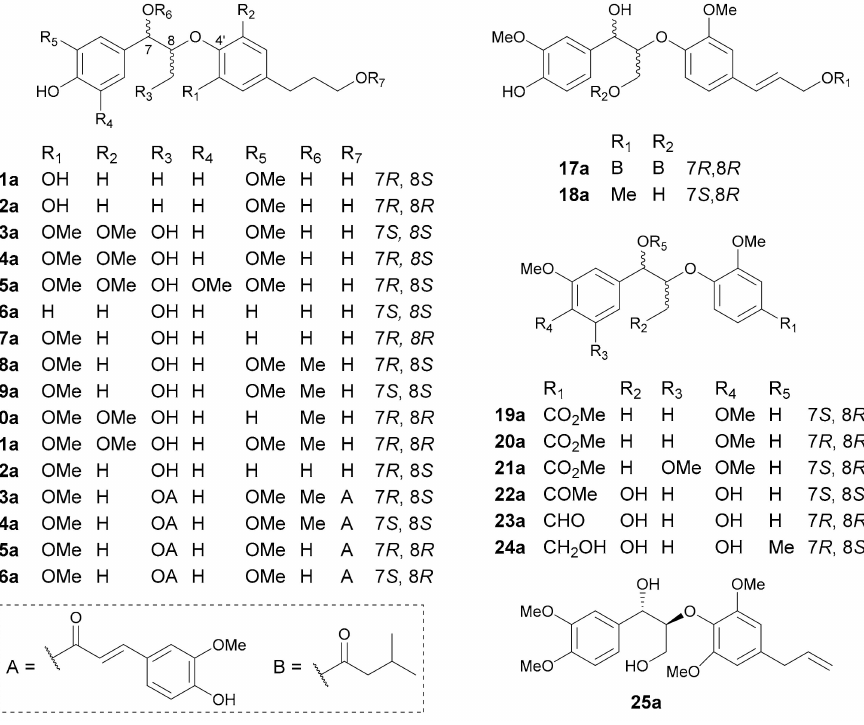
Figure 1. Structures of 8,4 (cid:48)